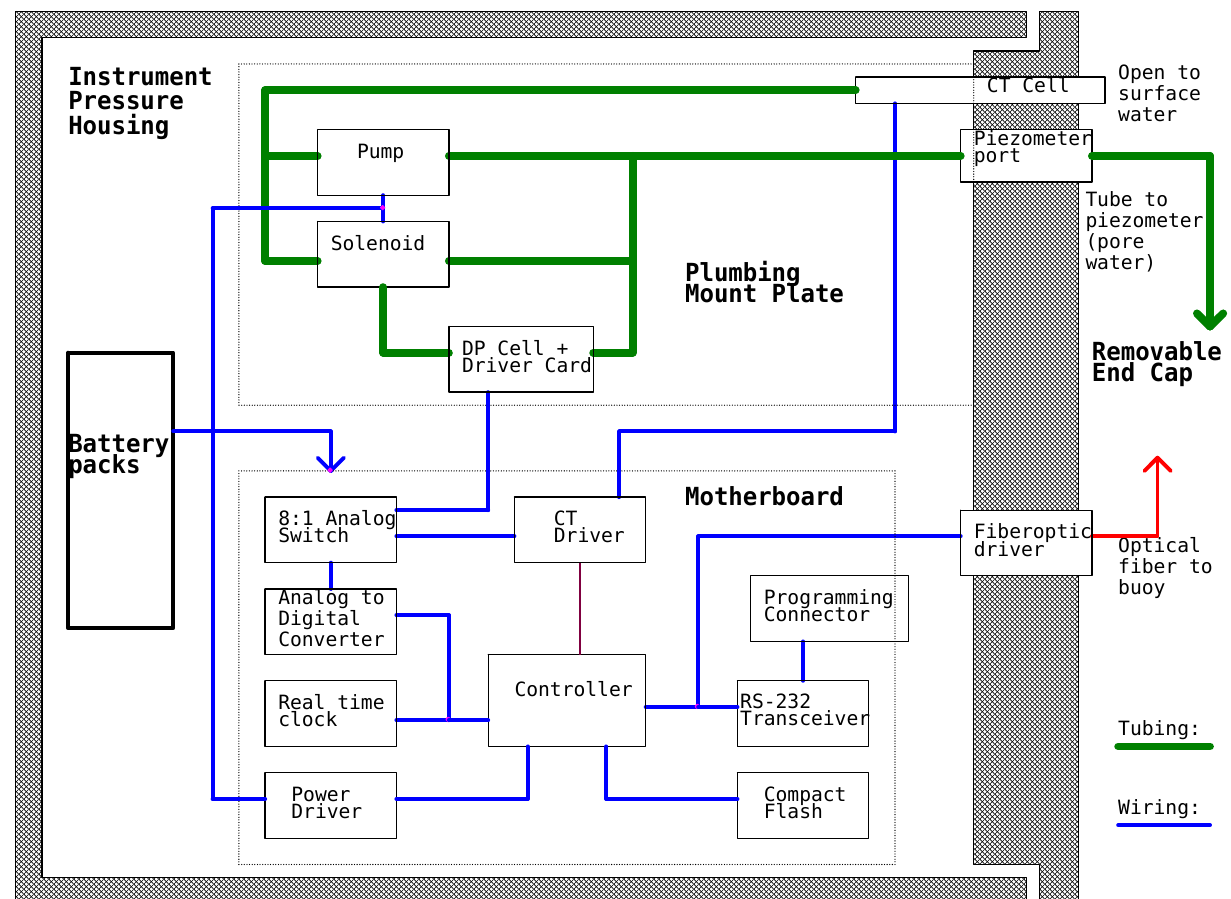
Figure 1. Functional block diagram of the DP logger showing major fluid flow and electrical